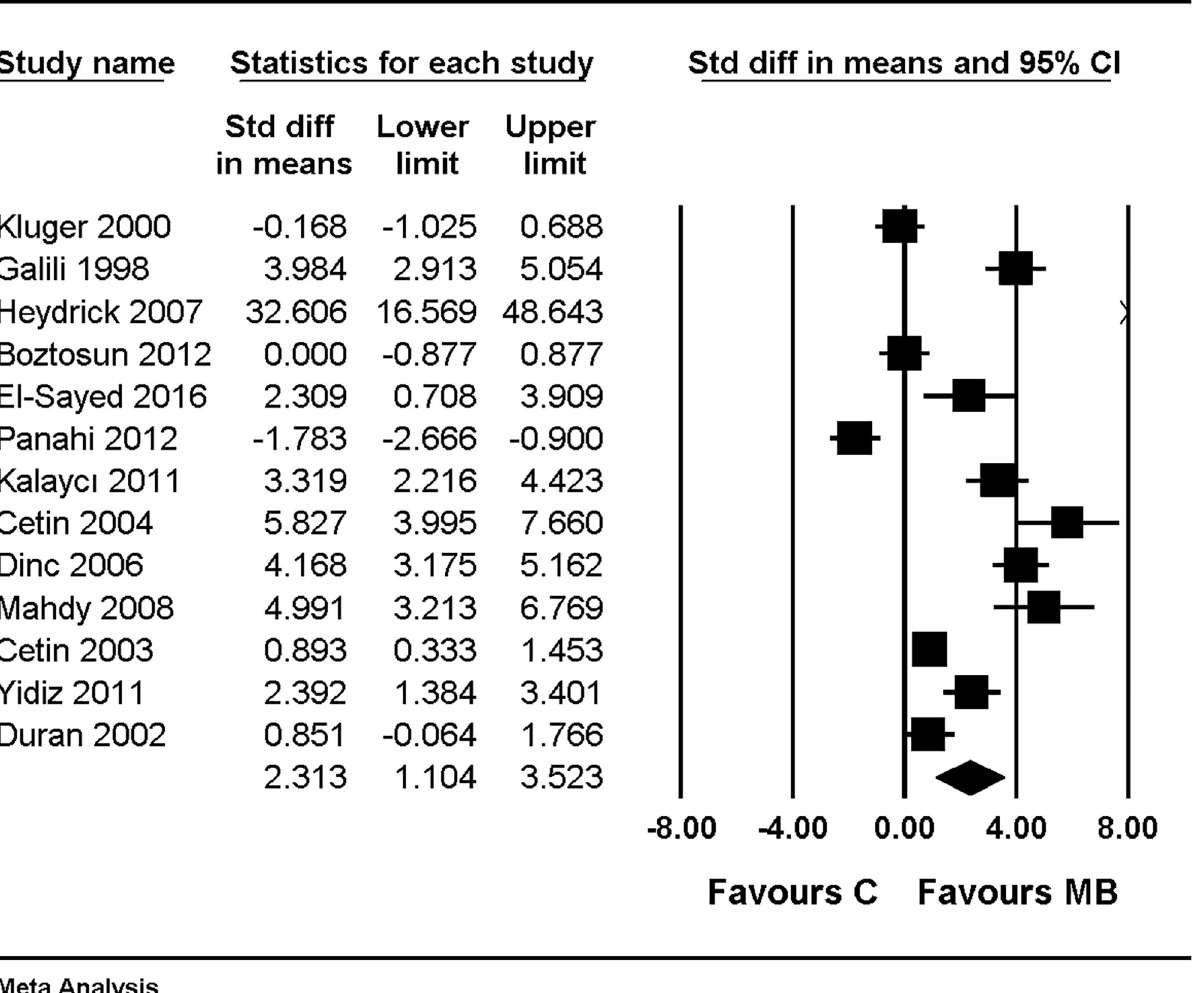
Fig 2. Forest plot showing an overall effect of macroscopic adhesion score compared with the combined results of using saline and nothing as control. The figure depicts individual trials as filled squares with relative sample size and the 95% confidence interval (CI) of the difference as a solid line. The diamond shape indicates the pooled estimate and uncertainty for the combined